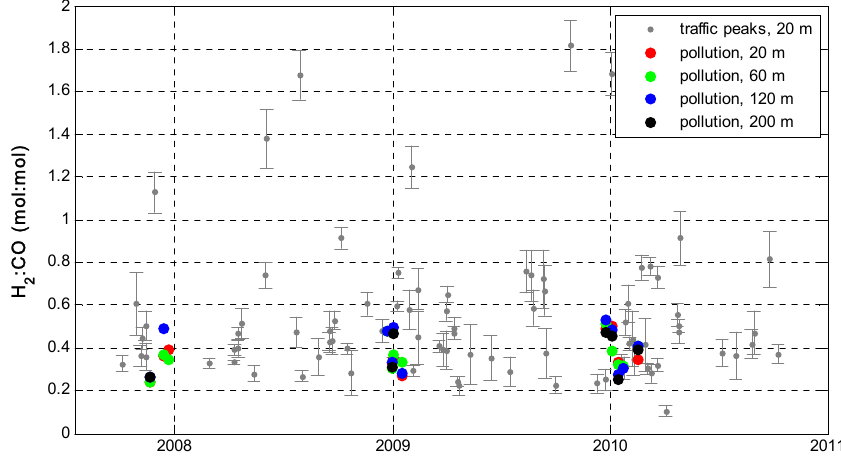
Fig. 10. H 2 /CO ratios of large scale pollution events, for the four sampling heights. Overlapped are the ratios of the morning traffic peaks, for comparison. The results are not corrected for the concurrent soil